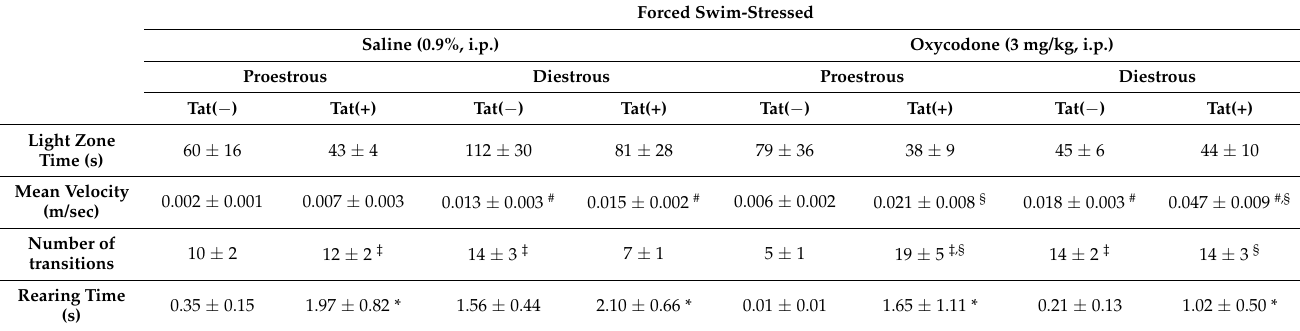
Table 2. Motor and anxiety-like measures for Tat( − ) and Tat(+) female mice assessed in open field and light-dark transition tests. Proestrus or diestrous mice were exposed to a forced swim stress prior to administration of saline or oxycodone. * indicates a main effect of genotype wherein Tat(+) mice differ from Tat( − ) controls. # indicates a main effect of estrous cycle wherein diestrous mice differ from proestrous mice. § indicates an interaction wherein oxycodone-administered Tat(+) mice differ from respective Tat( − ) controls and saline-administered controls. ‡ indicates an interaction wherein proestrous Tat( − ) mice differ from respective Tat(+) and diestrous Tat( − ) controls, p < 0.05. Forced Swim-Stressed Saline (0.9%,